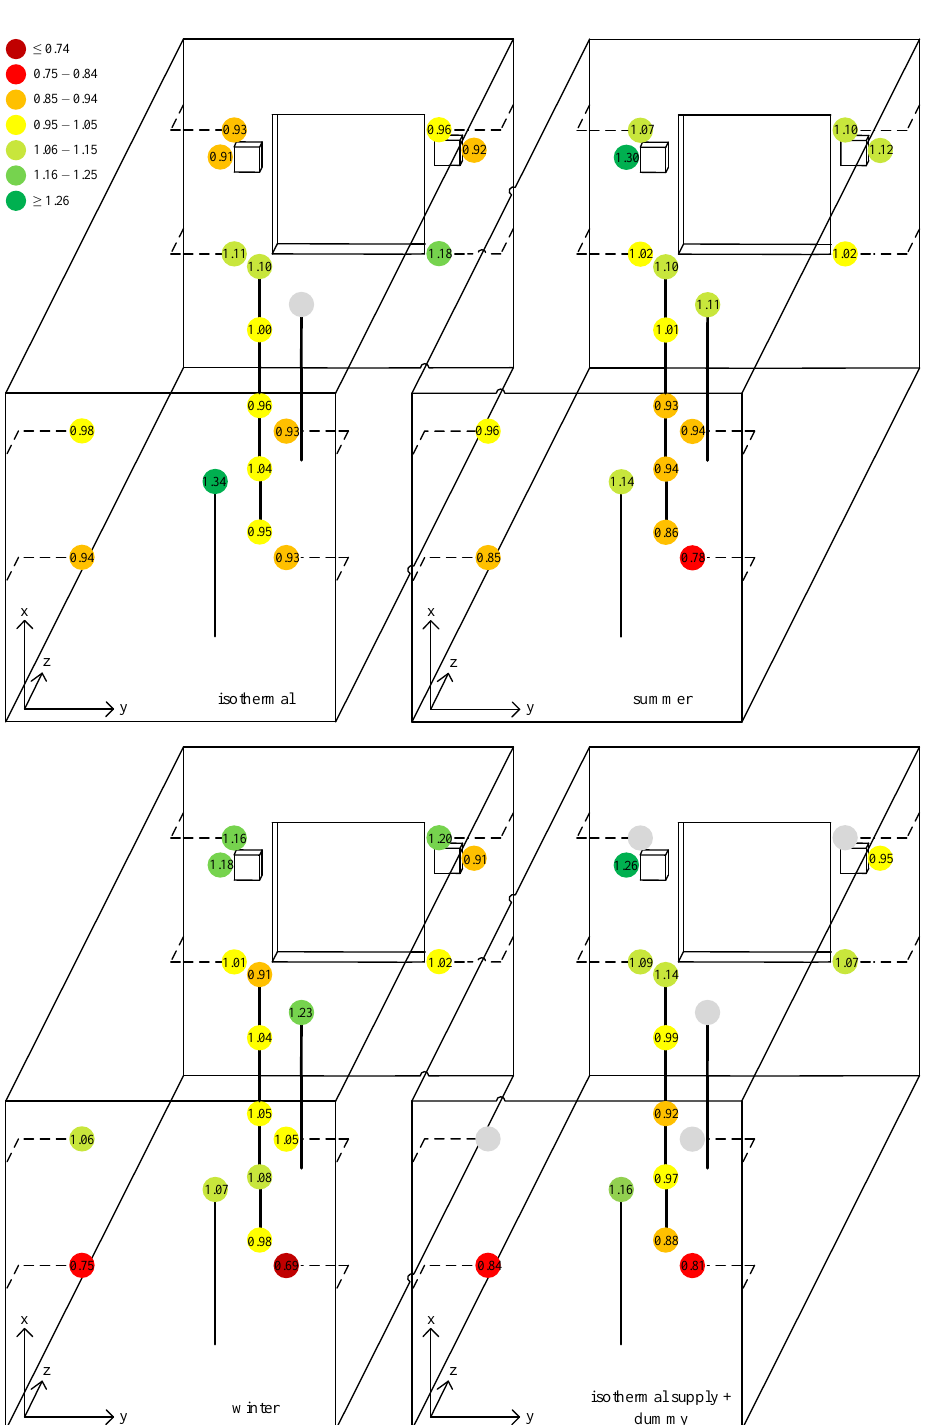
. Figure 6. Local air exchange indices ε a (2–3) at V = 15 m 3 · h − 1 : isothermal ( top left ), summer ( top right ), Figure 6. Local air exchange indices ε N,ja (2–3) at V ̇ = 15 m³ ⋅ h -1 : isothermal ( top left ), summer ( top N,j winter supply air conditions (bottom left), isothermal supply air conditions plus placement of a dummy right ), winter supply air conditions ( bottom left ), isothermal supply air conditions plus placement of to simulate human heat dissipation of 300 W ( bottom right ) a dummy to simulate human heat dissipation of 300 W ( bottom right ) [36] .